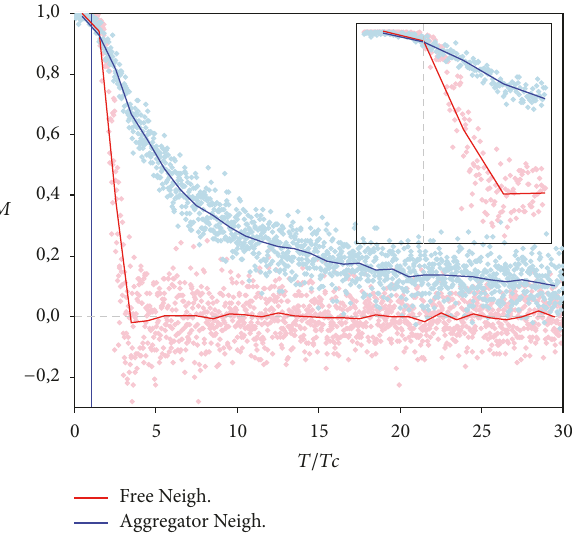
Figure 8: Aggregator boundaries and total magnetisation. Standard evolution (red) compared with another evolution where spins interact only with neighbours belonging to the same aggregator (blue). Dots represent 100 realisations for each 𝑇 and lines show averaged values ( 𝑇 𝑐 shown in blue vertical line). The inset zooms in the solutions where there is a phase-like transition at 𝑇/𝑇 𝑐 (grey dotted